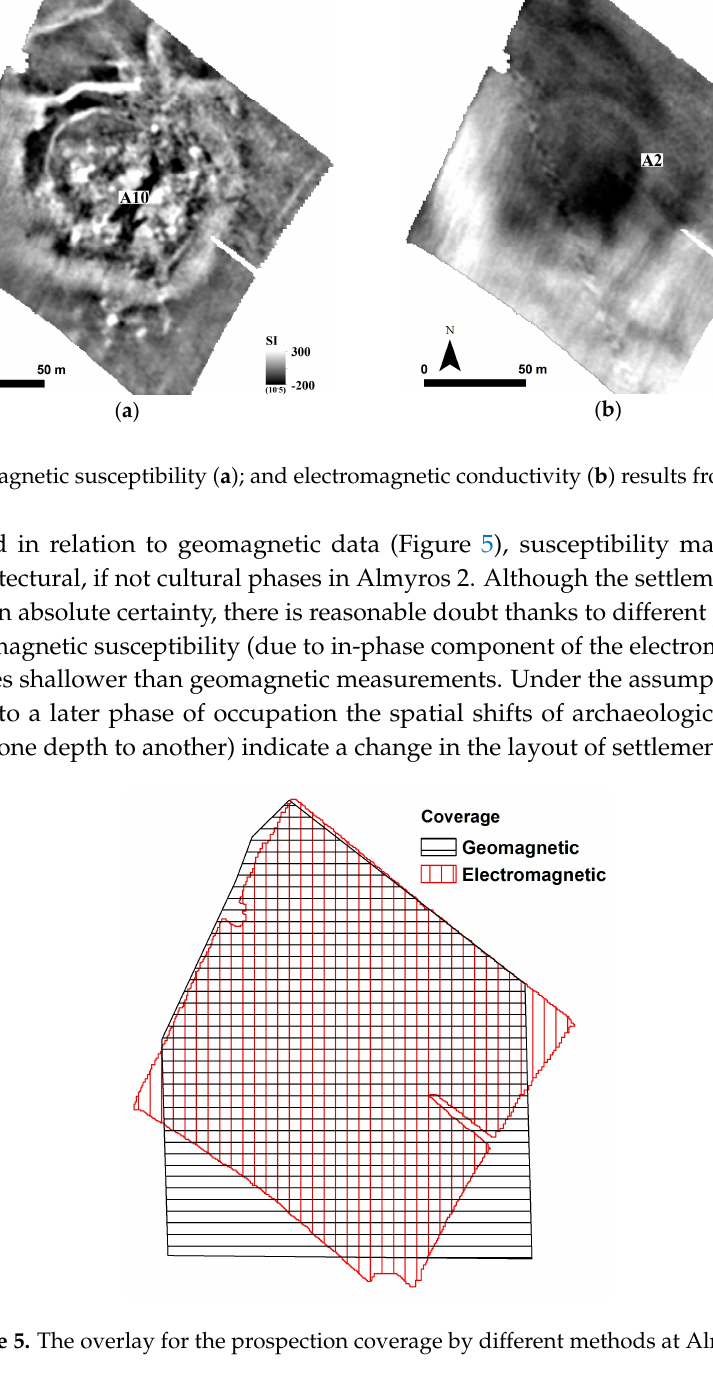
Figure 5. The overlay for the prospection coverage by different methods at Almyros 2.